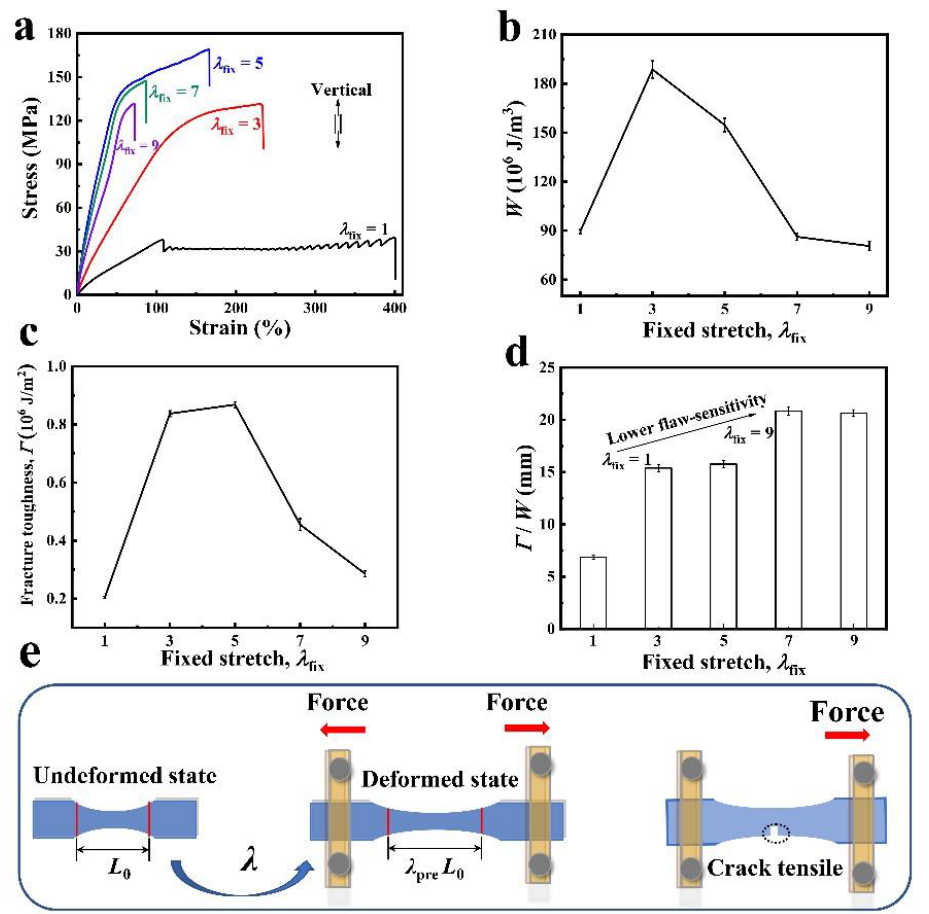
Figure 5. The analysis of the effect on fracture toughness prescribed by λ fix of chain-extended PBS. ( a ) The stress–strain curve shows the sample becomes stiffer in the aligned direction with increasing λ fix . ( b ) The work of tension W of the sample is the integral of stress–strain curve with a pre-stretch ratio. ( c ) The relationship between the fracture toughness Γ and pre-stretch ratios. ( d ) The critical flaw sensitivity length scale Γ / W of the sample becomes a measure of lower notch sensitivity with increasing λ fix . ( e ) The PBS samples was pre-cut with an initial crack 0.2 times the width of the sample. An initial flaw ( ≈ 0.8 mm) in an unaligned pristine sample quickly propagates throughout the sample once the tensile spline is stretched, while the chain extension sample is slowly pulled apart. The notched tension of the virgin sample and the chain extension sample ( λ fix = 1) can be observed in Movie